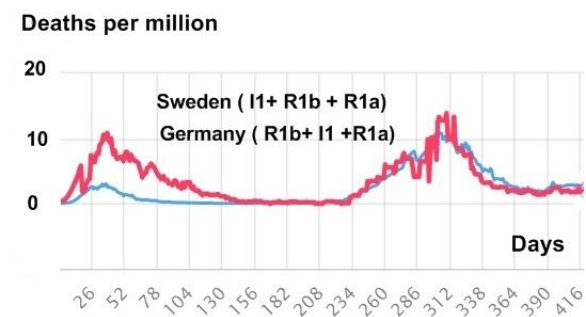
Figure 10. Czech Republic, deaths per million during 1 and 2 lock- downs. The blue line is the first lockdown; the red line is the second lockdown. The dots indicate the beginning and end of the